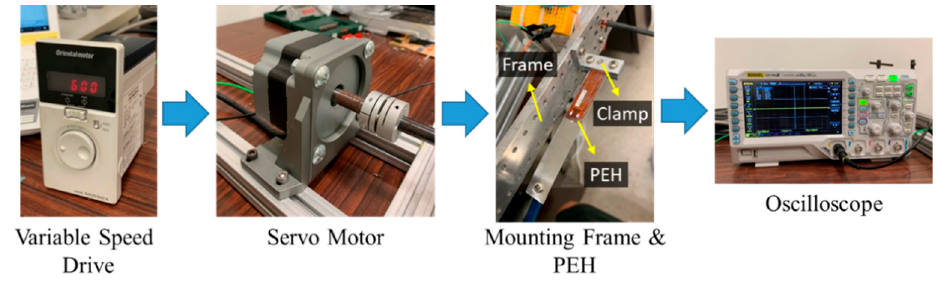
Figure 4. Experimental setup.